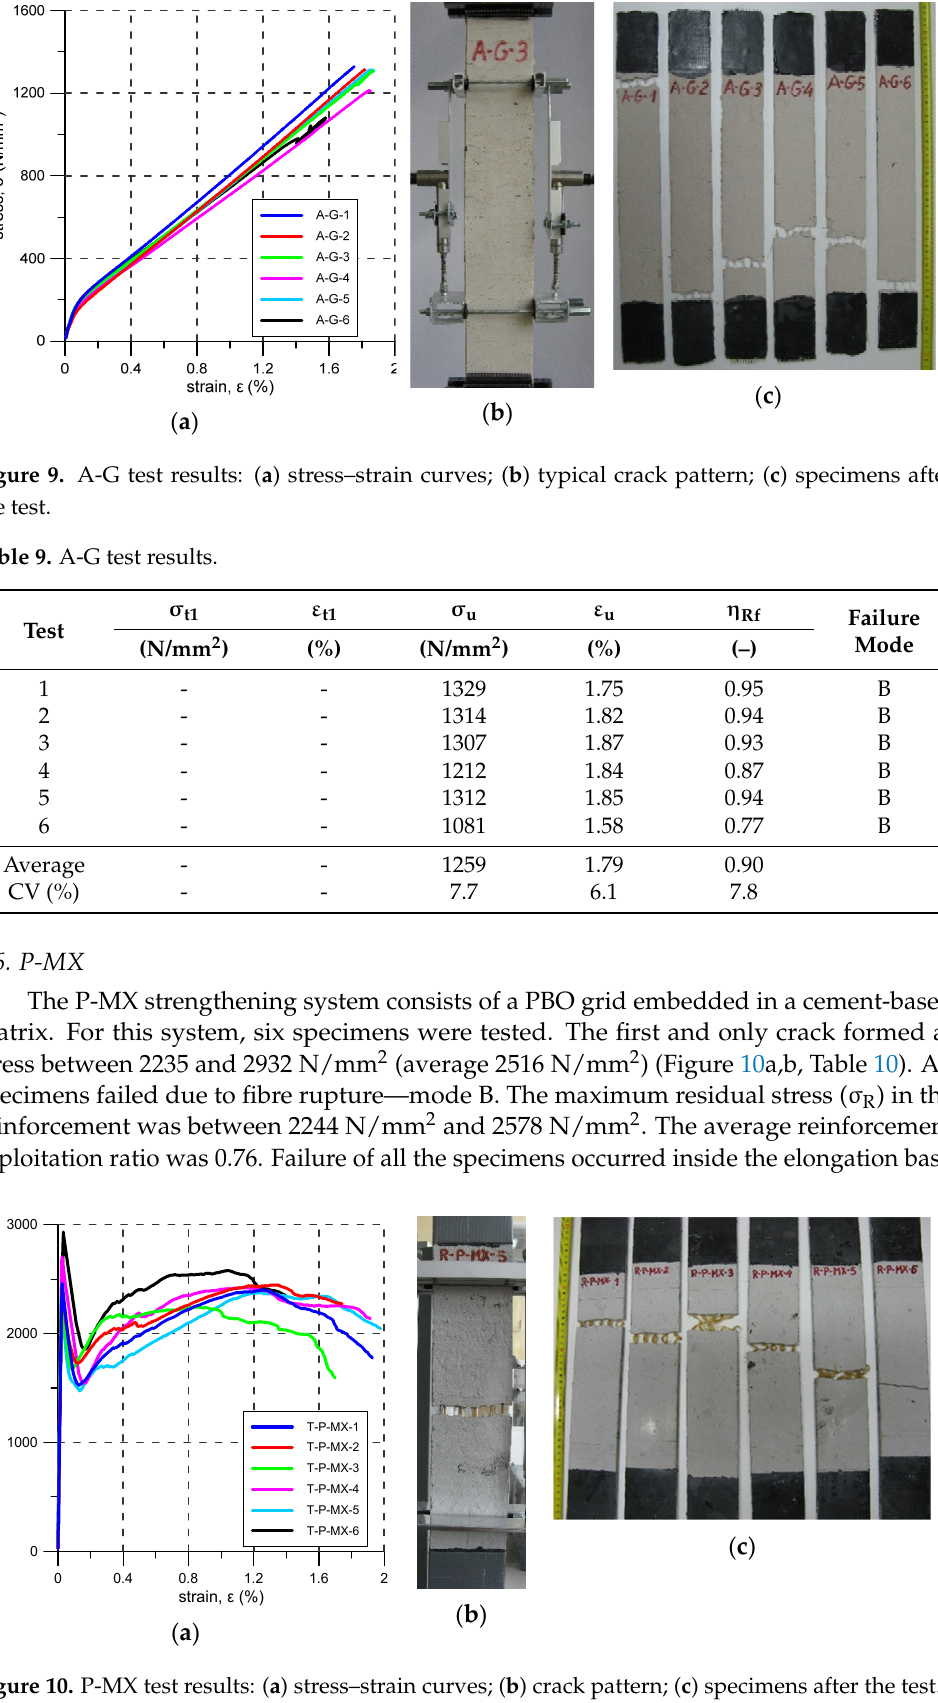
Figure 10. P-MX test results: ( a ) stress–strain curves; ( b ) crack pattern; ( c ) specimens after the test. Table 10. P-MX test results.